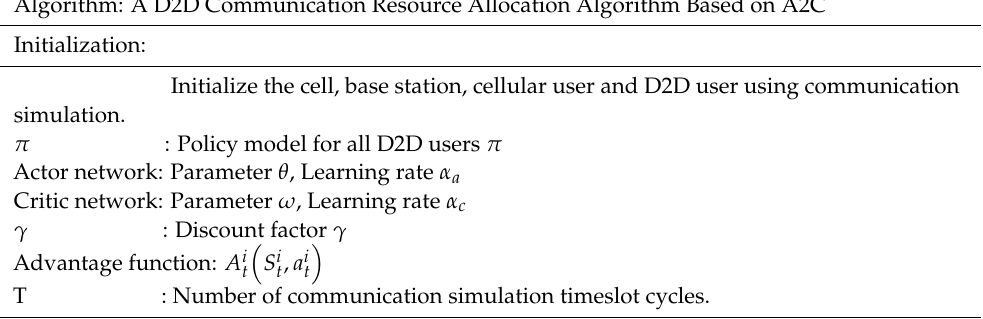
Algorithm 1. D2D communication resource allocation algorithm Algorithm: A D2D Communication Resource Allocation Algorithm Based on